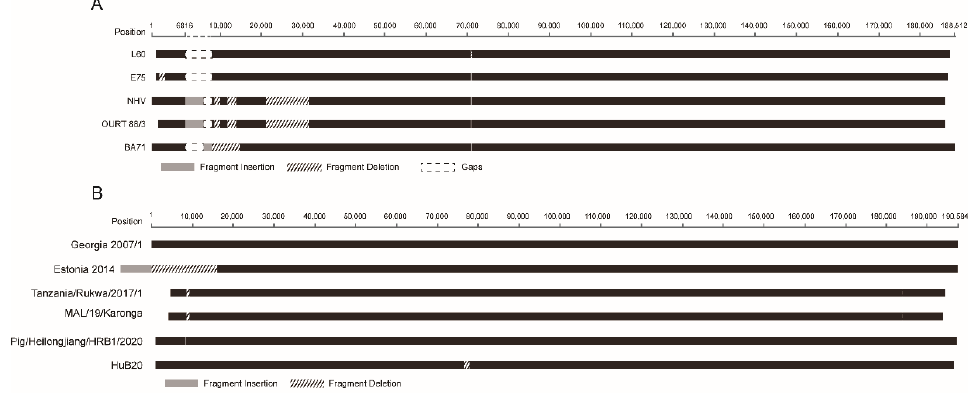
Figure 4. Structural variations in ASFV genotype I ( A ) and genotype II ( B ) genomes. Fragment insertion is shown in dark grey blocks. Fragment deletion is shown in dashed blank blocks. Blank blocks indicate gaps introduced for alignment purposes. Nucleotide position in the reference genome L60 ( A ) and genome Georgia 2007/1 ( B ) is shown.